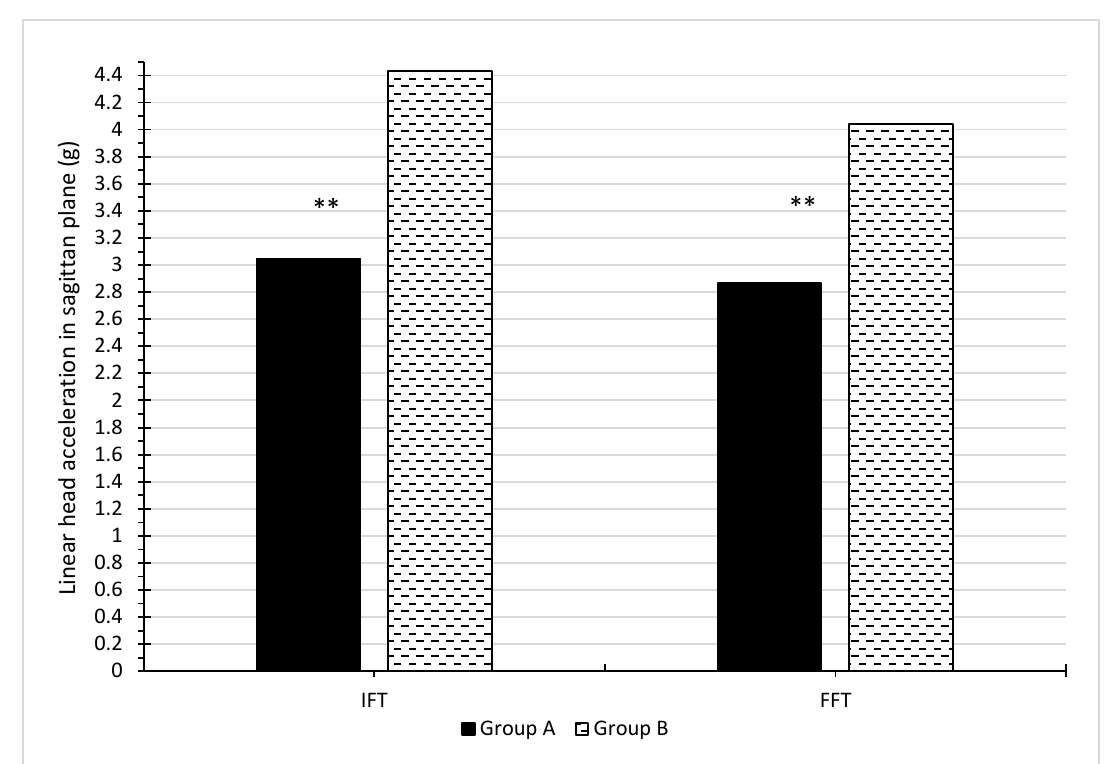
Figure 9. Comparison mean delta values for IFT and FFT between groups A and B (** means a sig- nificant difference between the mean values provided at the significance level 0.01).